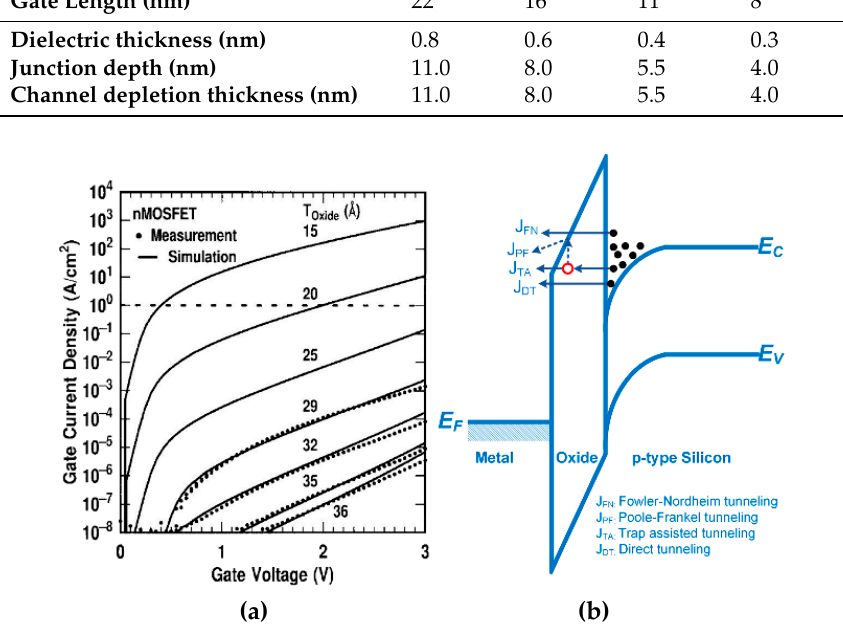
Figure 1. ( a ) Gate leakage current for nMOSFETs with different gate dielectric thicknesses [5], and ( b ) energy band diagram of an nMOS structure showing major tunneling mechanisms .